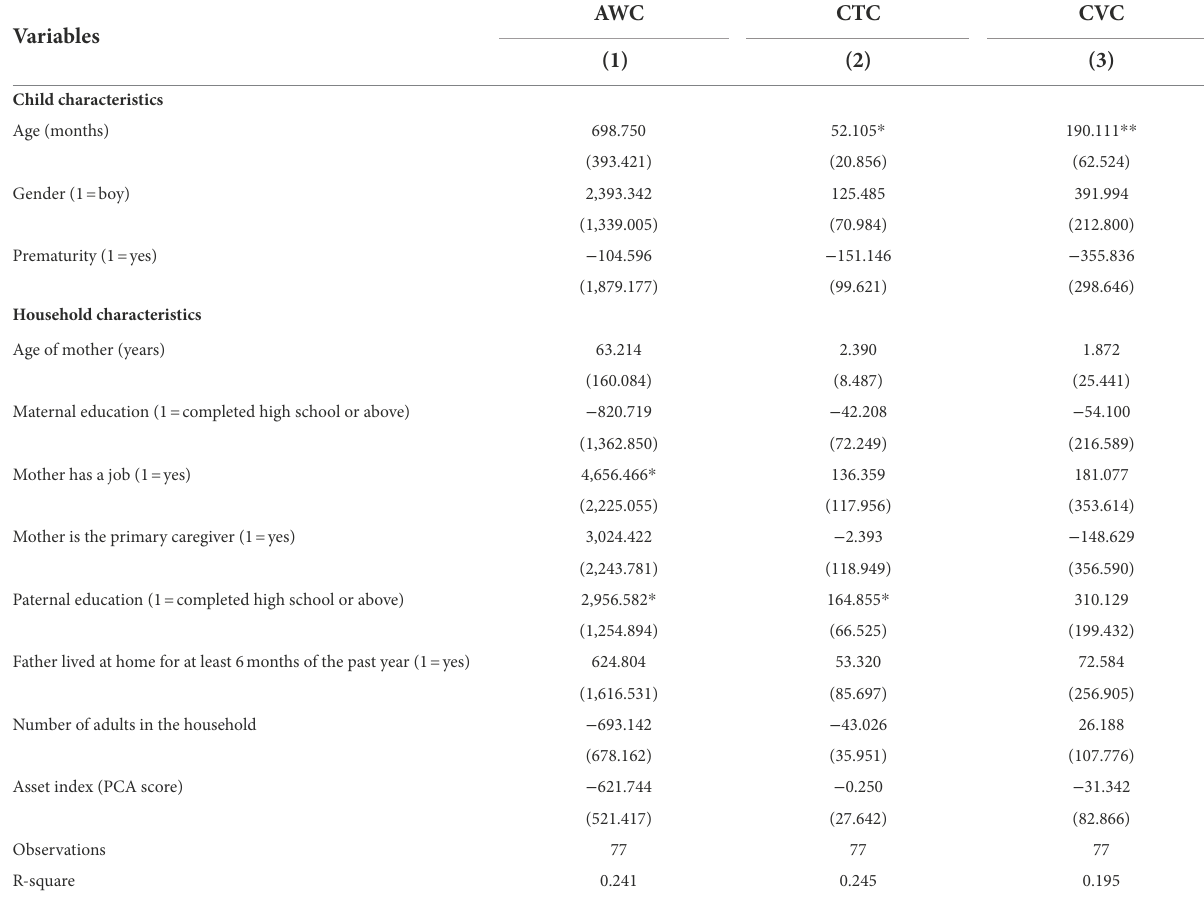
TABLE 5 Multivariate correlations between household characteristics and Adult Word Count (AWC), Conversational Turns Count (CTC), and Child Vocalization Count (CVC).